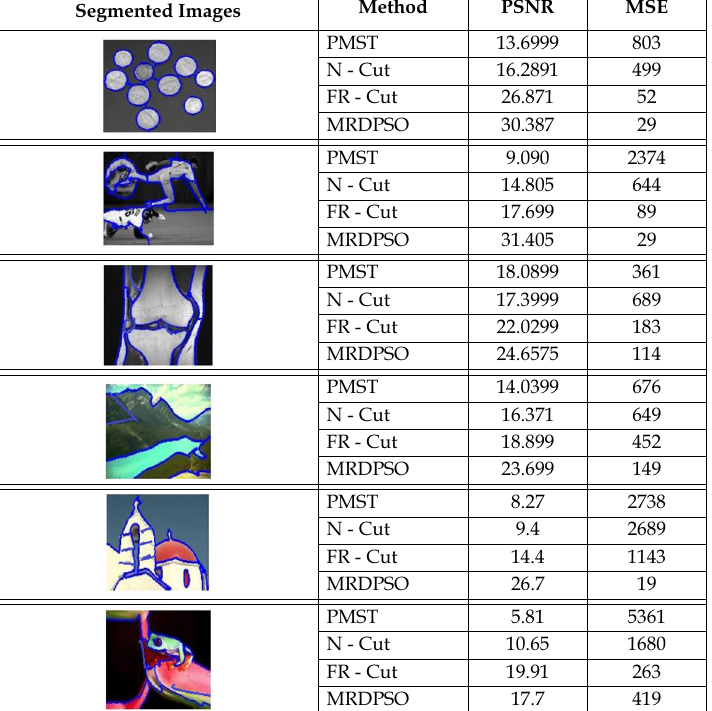
Table 2 RSNR and MSE for test images Segmented